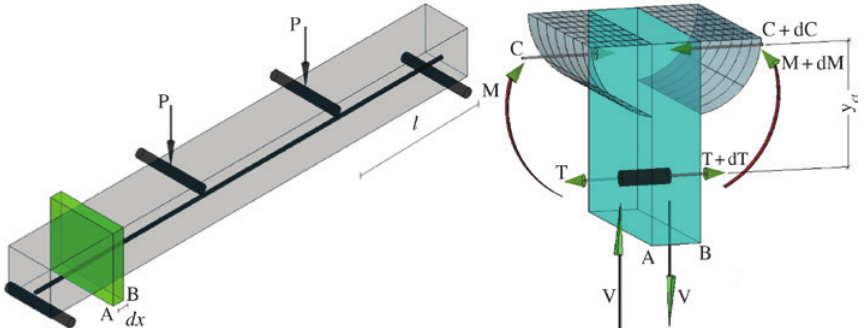
Figure 1: Flexural stresses in a part